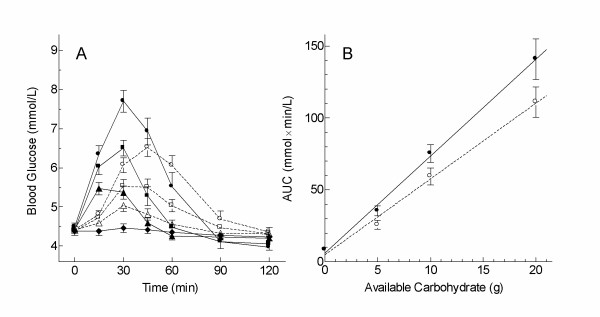
Blood glucose responses elicited by various doses of oral glucose and white bread. A: blood glucose concentrations after 0 (◆), 5 (▲), 10 (■), 20 (●) glucose and 5 (△), 10 (□) and 20 g (○) carbohydrate portions of white bread (each dose tested 2 times in 20 subjects); B linear regression of mean incremental areas under the curve (AUC) on grams carbohydrate (g) for glucose (●; AUC = 6.74 g + 6.0; r2 = 0.997, p = 0.0014), and white bread (○; AUC = 5.28 g + 4.9; r2 = 0.992, p = 0.0038). Points are means ± SEM.